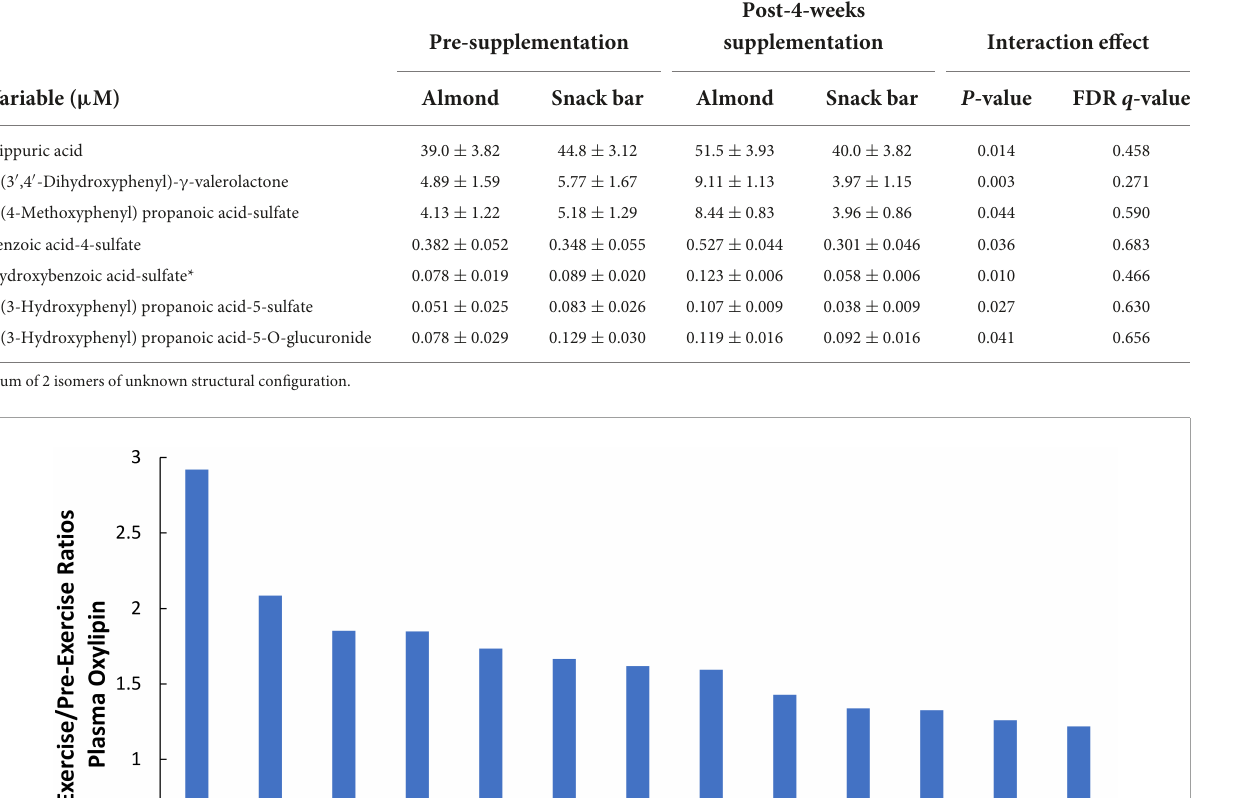
TABLE 6 Urine concentrations (24 h collection) of gut-derived phenolics before and after 4-weeks supplementation with almonds (57 g/d) or cereal bars (calorie matched).